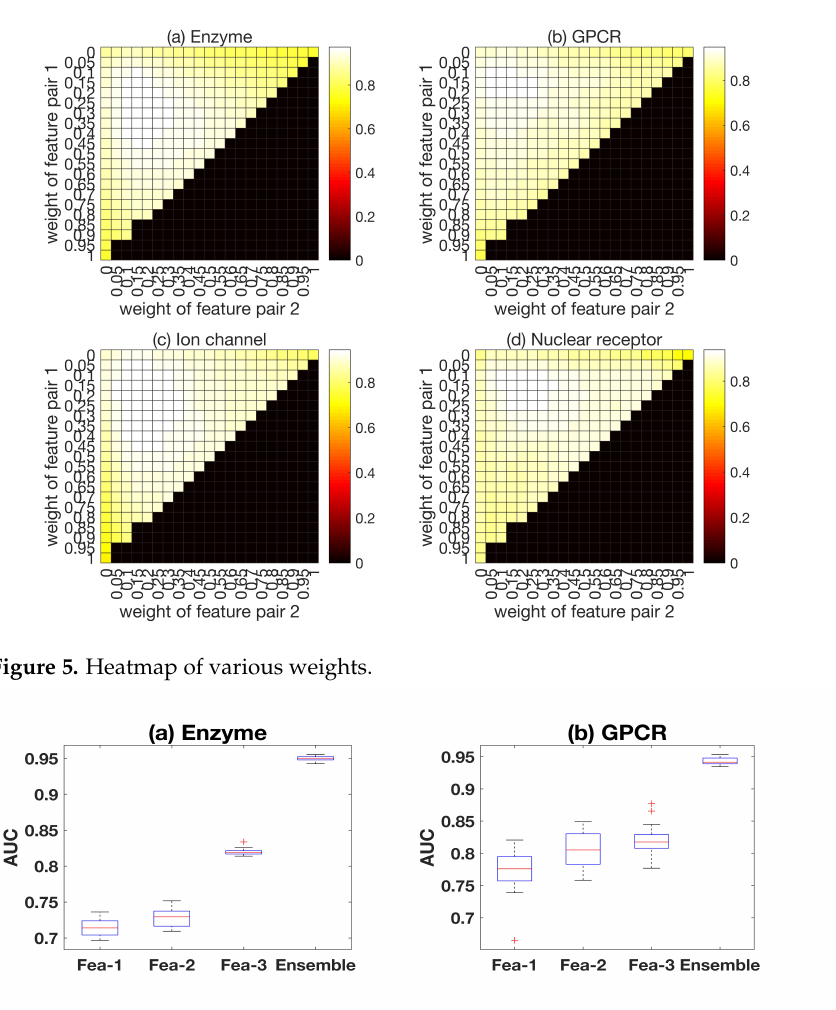
Figure 6. Comparison between Ensemble Models and Individual